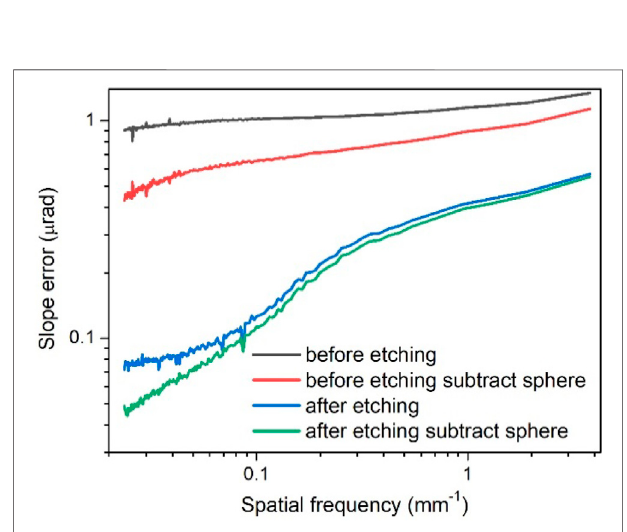
after IBF was only 1.1 nm (RMS) ( Figure 6D ).